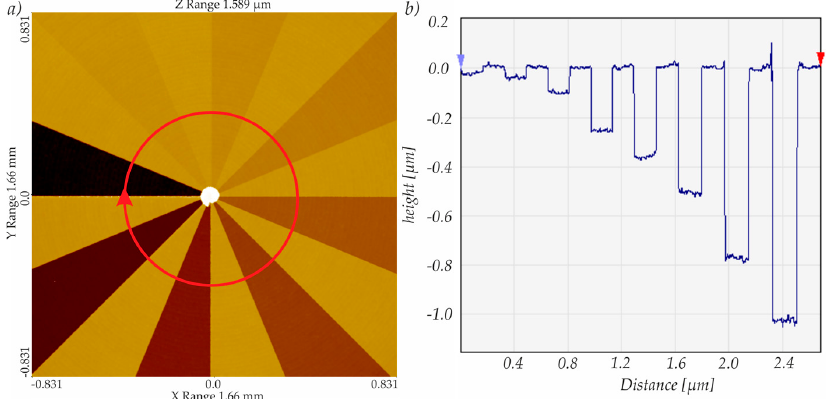
Figure 6. ( a ) Light interferometric measurement of the structure transition in the cutting direction and ( b ) a circular cross section.